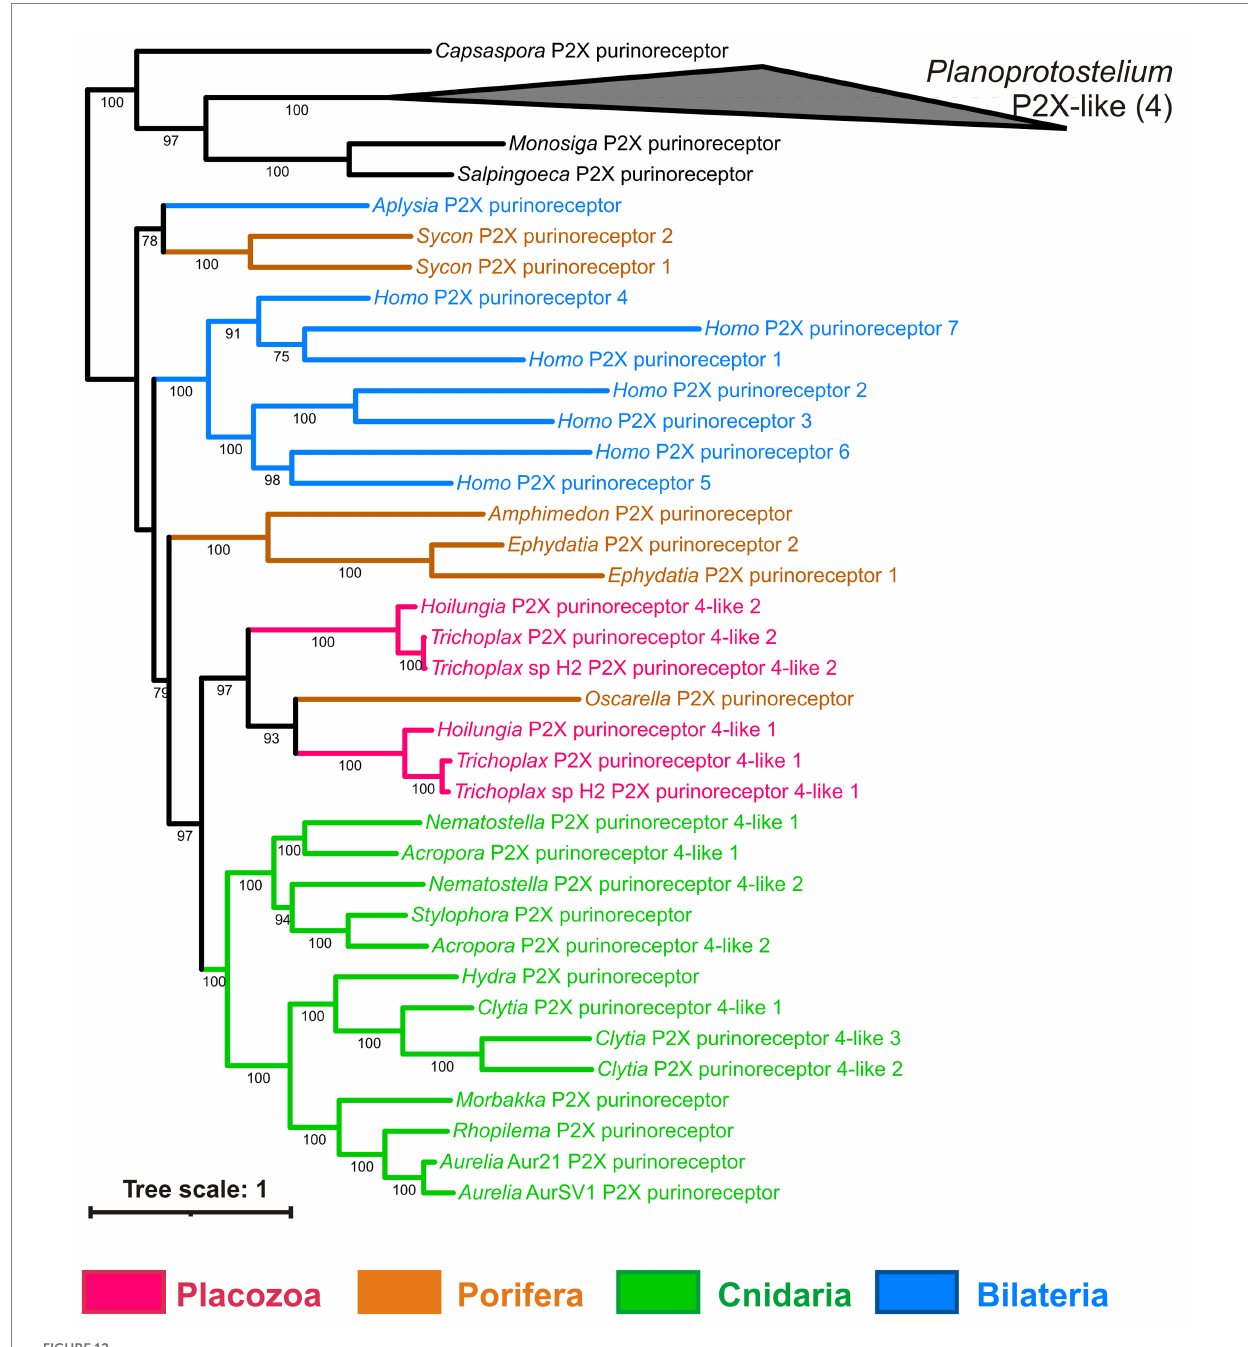
FIGURE 12 Bayesian phylogenetic tree of ionotropic purine (P2X) receptors. Trichoplax has 2 P2X receptors, and representatives of other invertebrate lineages have from 1 to 3 P2X receptors encoded in their genomes. Bayesian posterior probabilities of nodes (> 0.5) are